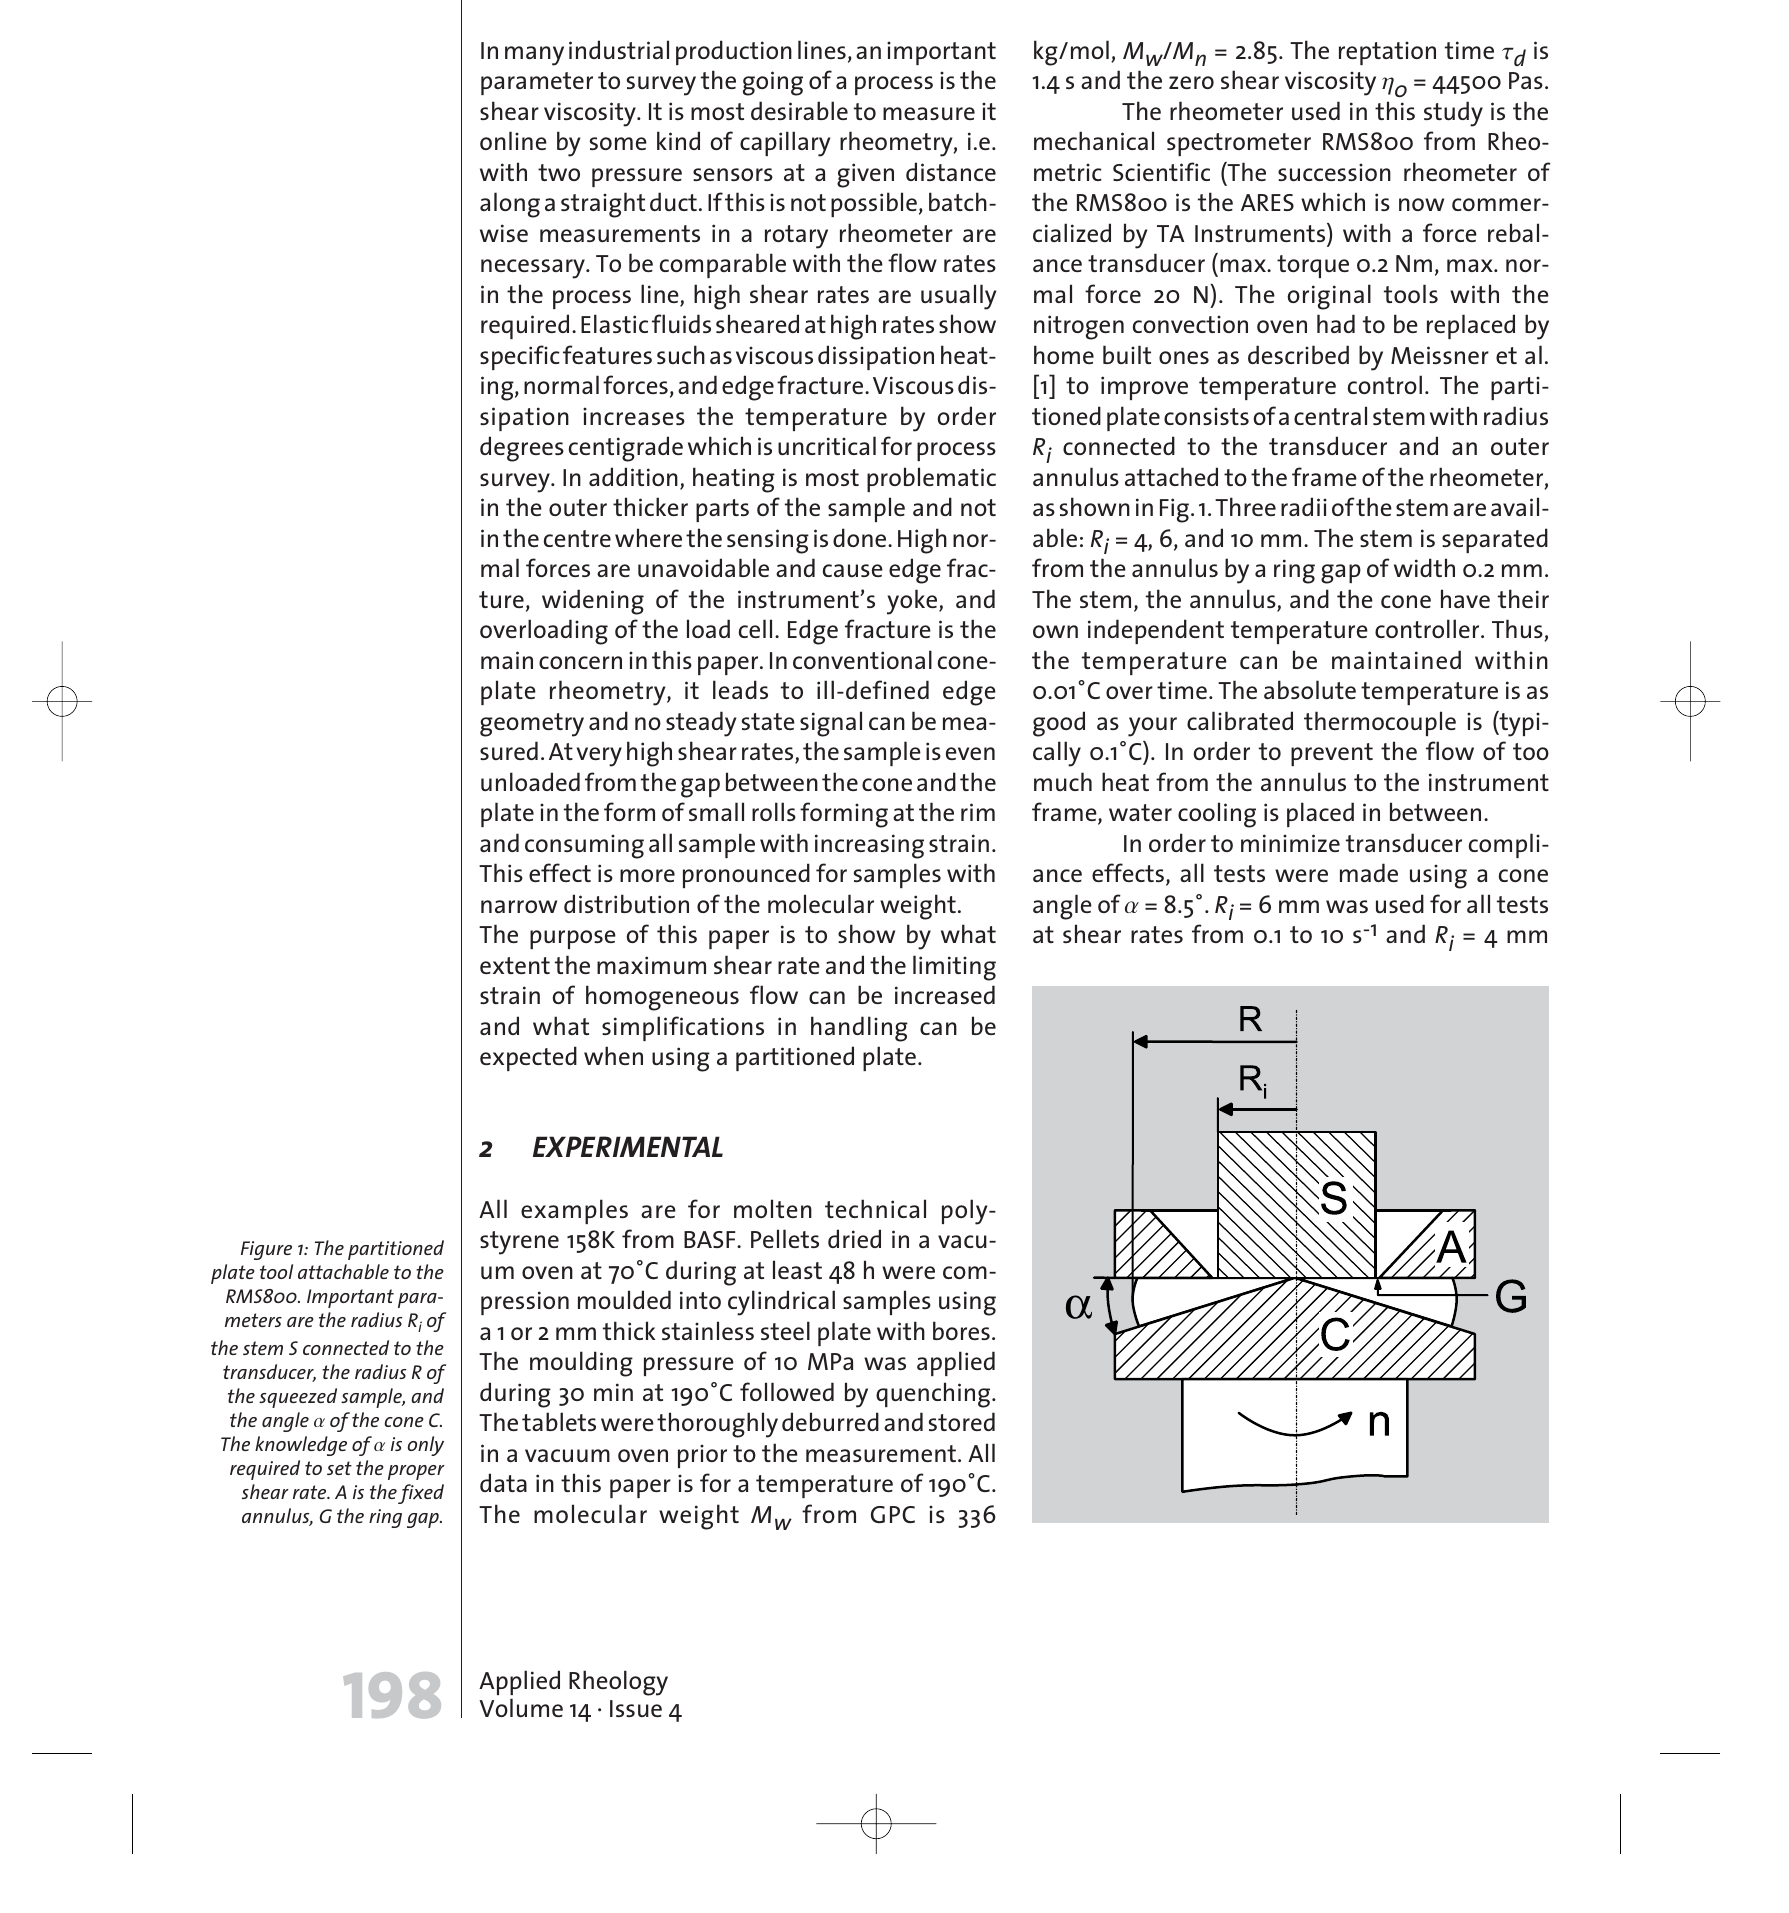
Figure 1: The partitioned plate tool attachable to the RMS800. Important para- meters are the radius R i of the stem S connected to the transducer, the radius R of the squeezed sample, and the angle a of the cone